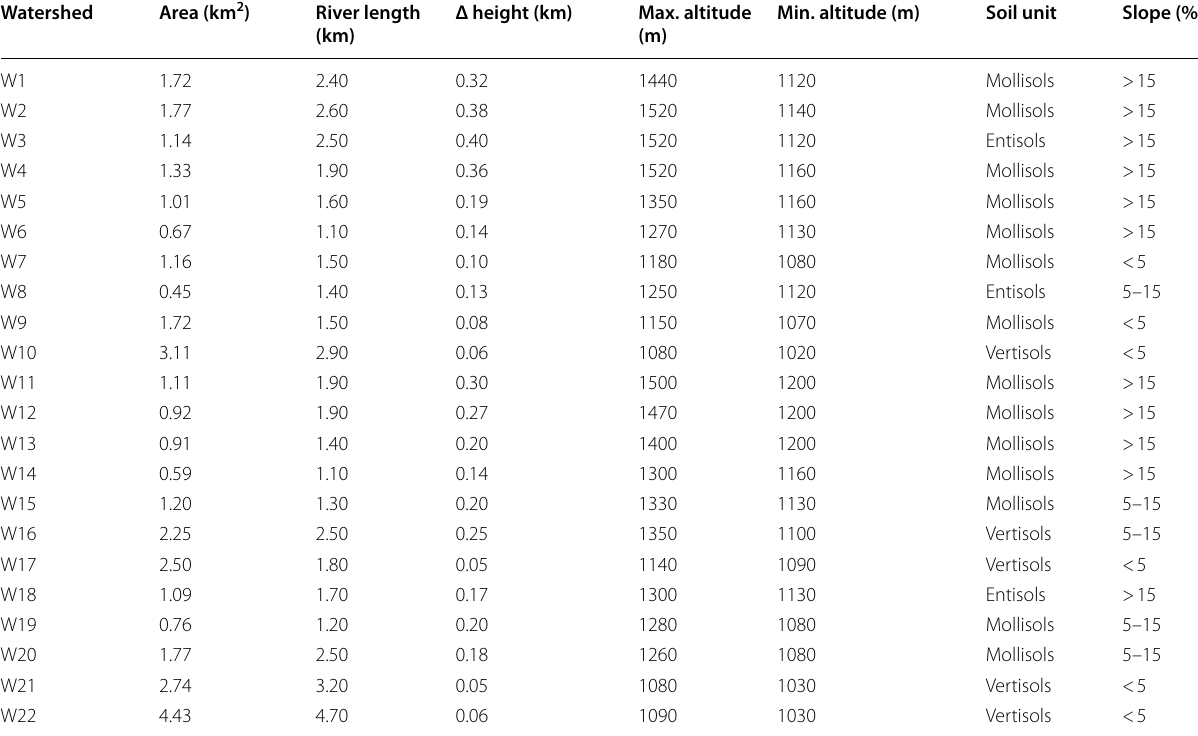
Table 2 Main physical characteristics of the watersheds